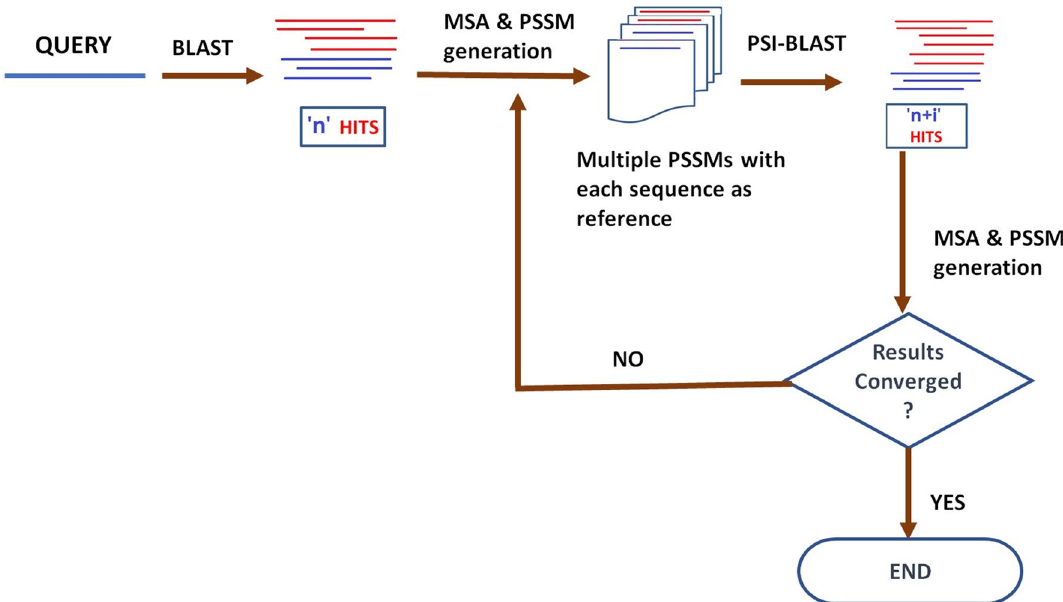
Figure 1. Flowchart of approach used for Master Blaster.